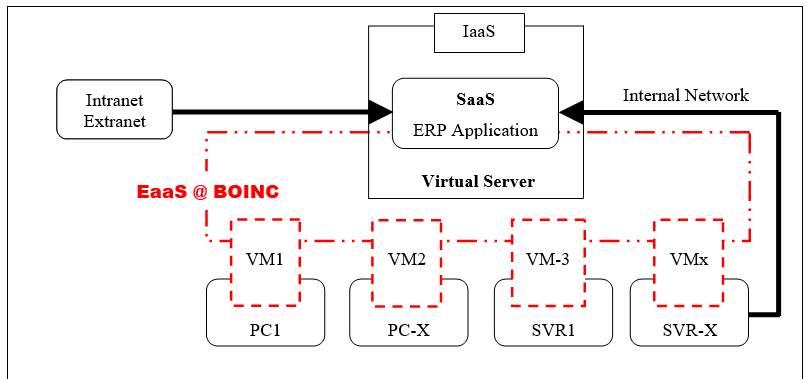
Figure 3. EaaS Architecture Using BOINC